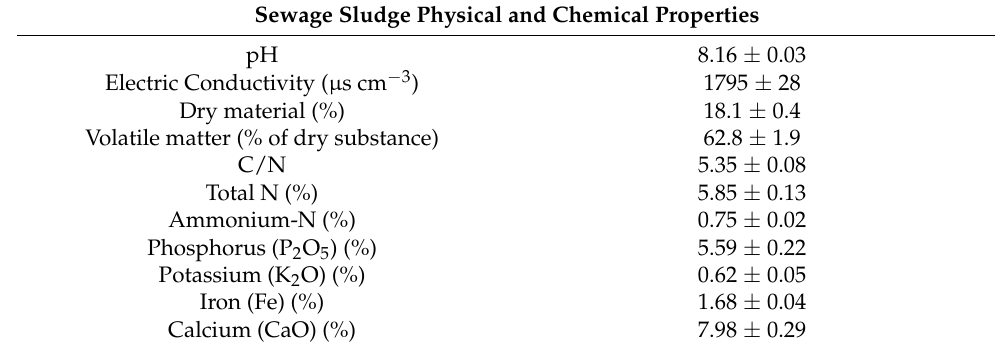
Table 2. Physical and chemical properties of the sewage sludge. Values are given as the mean ± standard deviation ( n =